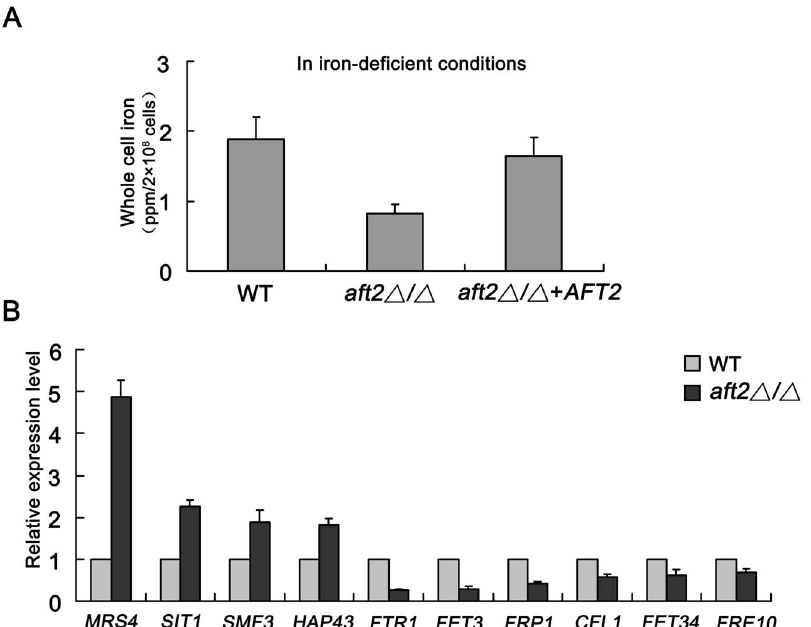
Figure 1. Effect of AFT2 deletion on iron content and iron-regulon expression under iron-deficient conditions. (A) Cells were pre-grown in YPD medium for 24 h at 30 u C, and re-cultivated in 100 ml fresh YPD + 100 m M BPS medium for 12 h, respectively. Then, cells were washed twice with sterilized PBS buffer, twice with 1 mM EDTA, and followed by twice with distilled deionized water to remove all exogenous iron. Measurement of cellular iron levels was performed by a Hitachi 180-80 polarized Zeeman atomic absorption spectrometry. Note: ppm= mg/kg. (B) Overnight cultures of the wild-type and aft2 D / D mutant strains were cultivated to mid-exponential phase in YPD + 100 m M BPS medium, and used for RNA isolation. Quantitative real-time PCR was performed to determine the relative expression changes of iron-responsive genes. Data indicate mean values 6 standard deviations from three independent experiments performed in triplicates.